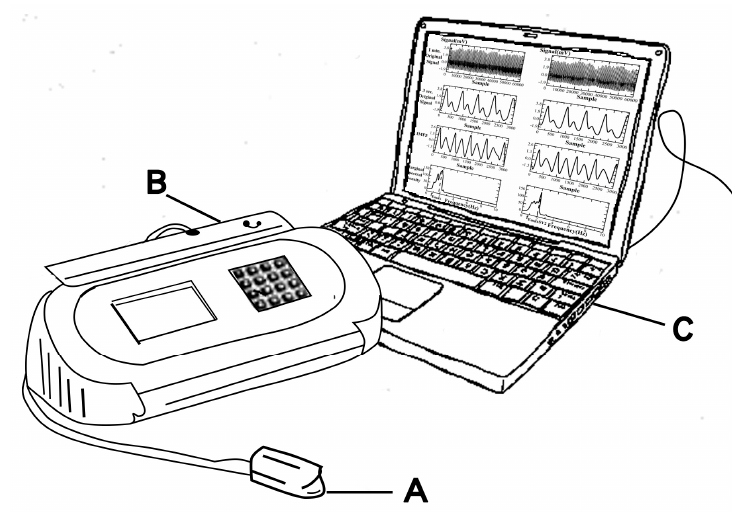
Figure 1. Photoplethysmographic electrical device (PED) system. This system consists of ( A ) one photoplethysmography sensor, ( B ) filtration and amplification circuits, and a USB-6008 DAQ, and